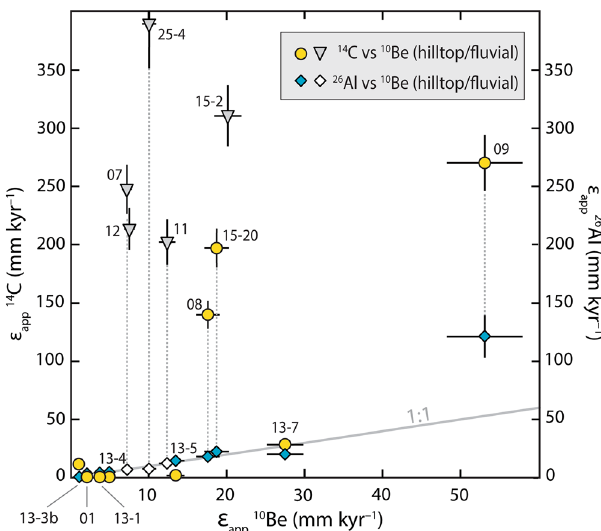
Fig. 3 Apparent erosion rates ( ε app ) determined from the measured 14 C, 26 Al and 10 Be concentrations. Sample pairs offset from the 1 : 1 grey line (i.e., yellow circles and grey triangles) indicate disequilibrium due to higher 14 C apparent erosion rate relative to 10 Be — a signal we attribute to erosional transience. The 26 Al apparent erosion rate of sample 09 is considered an outlier (see ‘ Methods ’ ). Error bars indicate ±1 σ